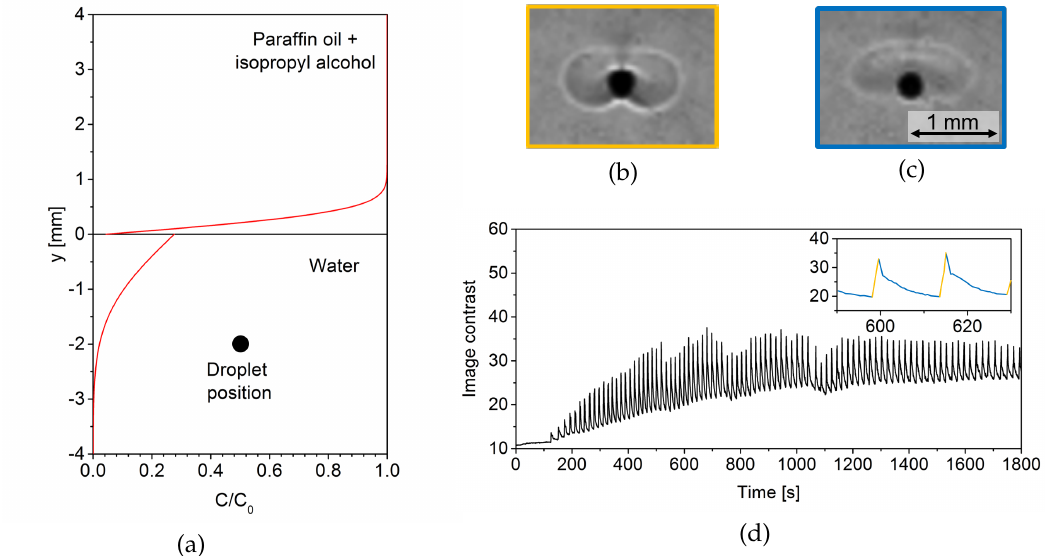
Figure 1. ( a ) The two-layer system paraffin oil/water with normalized concentration profile of isopropyl alcohol due to mass transfer out of the organic phase. The vertical position of a paraffin oil drop in the aqueous phase is marked by a black circle. ( b ) Active stage of relaxation oscillations at paraffin oil drop in the aqueous phase and ( c ) relaxation stage. ( d ) Time evolution of shadowgraph image contrast in the surrounding of the drop. The inset details two periods of relaxation